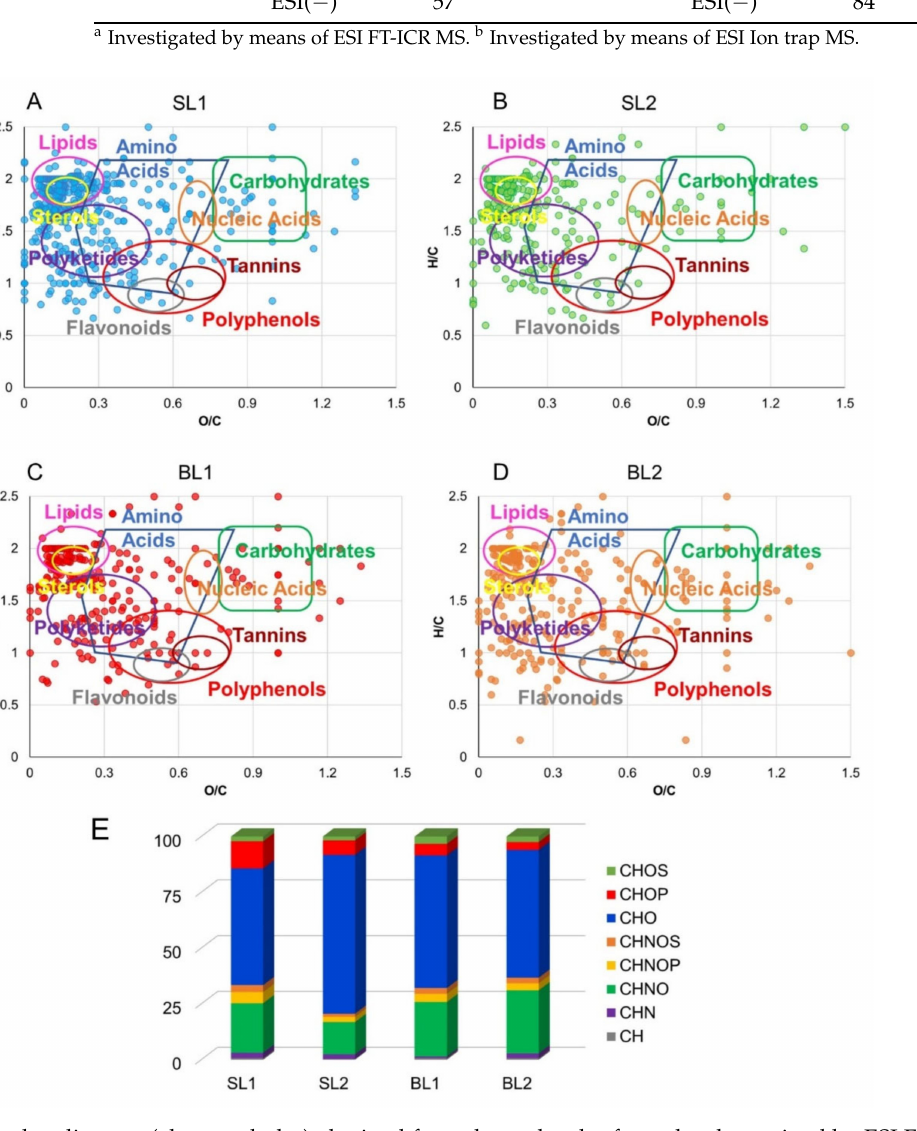
Figure 1. Van Krevelen diagram (elemental plot) obtained from the molecular formulas determined by ESI FT-ICR and Esquire 6000 MS analyses of hydroalcoholic and organic berries extracts of SL1 (panel A ), SL2 (panel B ), BL1 (panel C ), BL2 (panel D ). Each point represents a distinctive molecular formula. Relative frequency histograms of CH, CHN, CHO, CHNO, CHOP, CHOS, CHNOP, and CHNOS elemental compositions in SL and BL berries extracts ( E